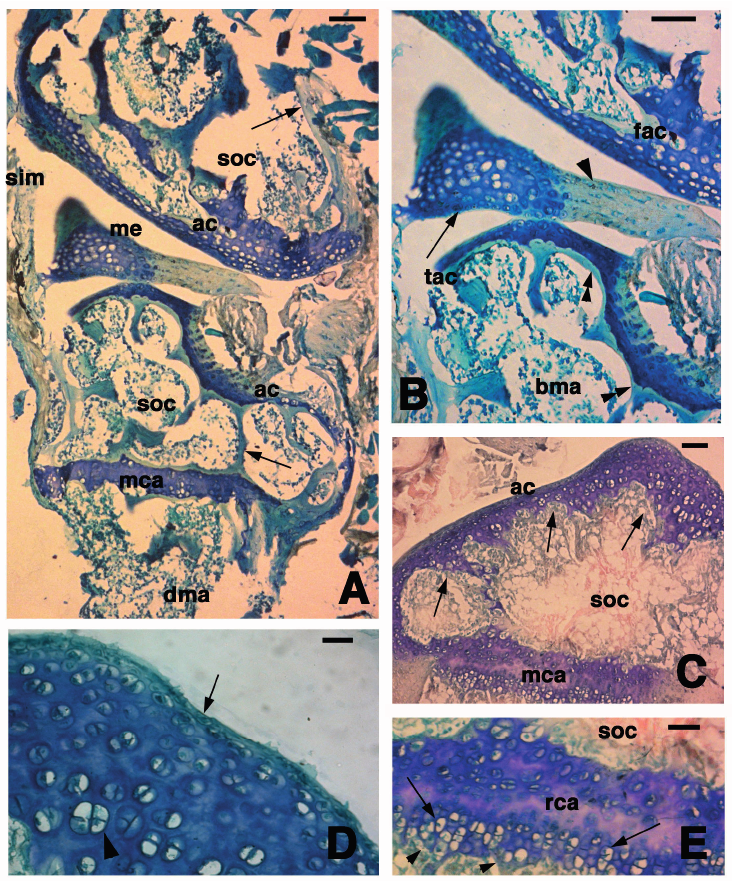
Figure 1. Histology of the articular epiphysis of the normal knee. ( A ) General aspect of the articular cartilage of the femur (top) and the tibia (bottom) with their secondary ossification centers (arrows indicate the bone trabeculae). Bar, 100 µm; ( B ) Detail of the articular surfaces of the femur and tibia with interposed meniscus made of a fibrous part (arrowhead) and a cartilaginous part (lunula, arrow). Bar, 50 µm; ( C ) Another section of a tibia showing the irregular thickness of the articular cartilage (arrows) surrounding the secondary ossification center. Bar, 50 µm; ( D ) Detail of the superficial region of the articular cartilage of a tibia showing flat cells (arrow) contacting the sinovial cavity and the relatively abundant extracellular ground substance among the isogenous groups (arrowhead) located within the cartilaginous mass. Bar, 20 µm; ( E ) Detail on the metaphyseal (growth) plate featuring serial resting cartilage bounding the hypertrophic cartilage (arrows) contacting the diaphyseal bone (arrowheads indicate bone trabeculae). Bar, 20 µm. Legends : ac, articular cartilage; bma, bone marrow; dma, bone marrow of the diaphysis; fac, femur articular cartilage; me, meniscus, mca, metaphyseal (growth) cartilaginous plate; rca, resting cartilage within the metaphyseal plate; sim, sinovial membrane; soc, secondary ossification center; tac, tibia articular